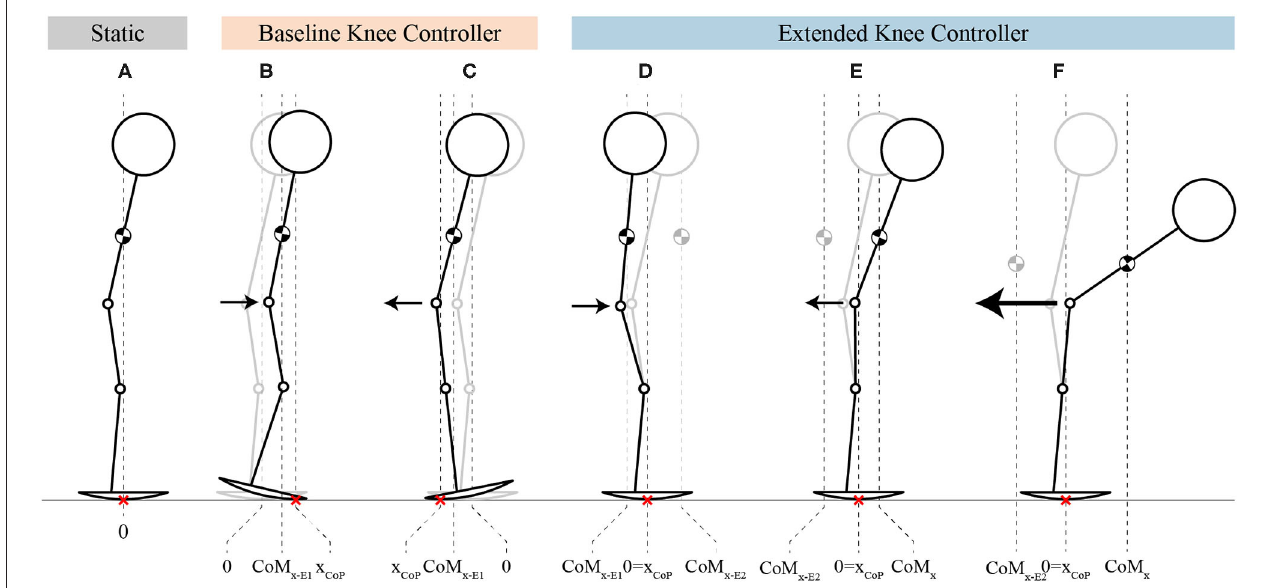
FIGURE 4 | Stick-figures showing the behavior of both controllers, at steady-state. (A) The stick-figure represents the initial rest position. (B,C) The stick-figures show the CoP displacement (x CoP ) and the behavior of the knees during push and pull perturbations, respectively, for BKC. (D–F) The stick-figures represent the behavior of EKC by showing how the position of the CoP is kept at the center of the foot thanks to the torso compensation for moderate push and pull perturbations, as well for strong pull perturbation. The arrows indicate the direction of the perturbation while their size is proportional to the perturbation amplitude. The red crosses represent the position of the point of contact with the ground, which is equivalent to the CoP in the sagittal axis (x CoP ). The gray stick figures in background are the initial equilibrium position, same as in (A) .